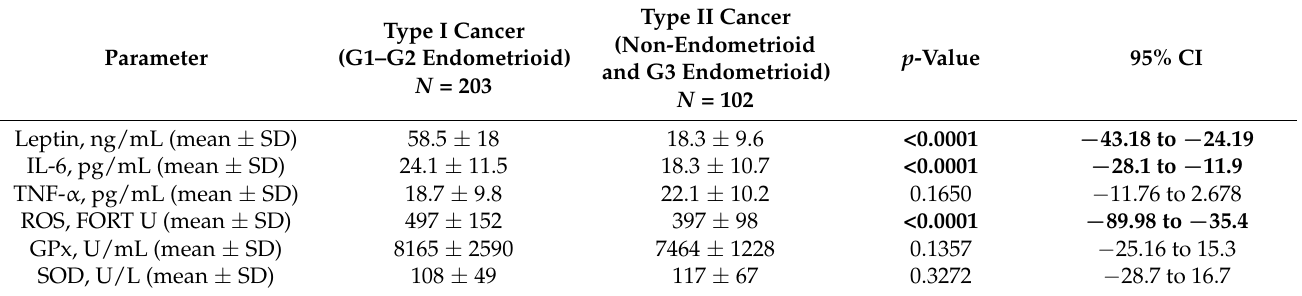
Table 3. Baseline laboratory parameters in endometrial cancer patients divided according to tumor type.